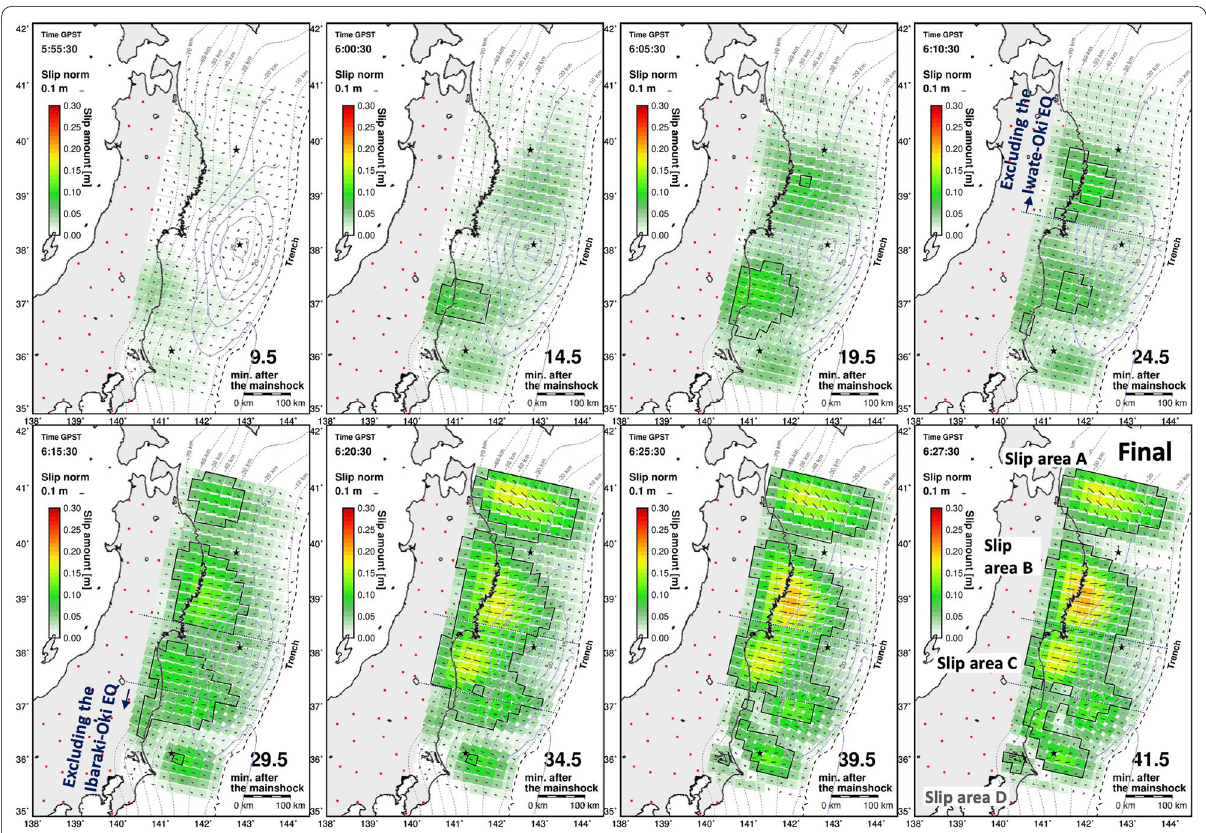
window of 5 min with a step of 30 s. The figures display every 5 min after the first “reset” and final result. All figures display differences between the and southern part of the fault zone, as indicated by the blue dotted line. Black outlines in each figure represent subfaults whose slip